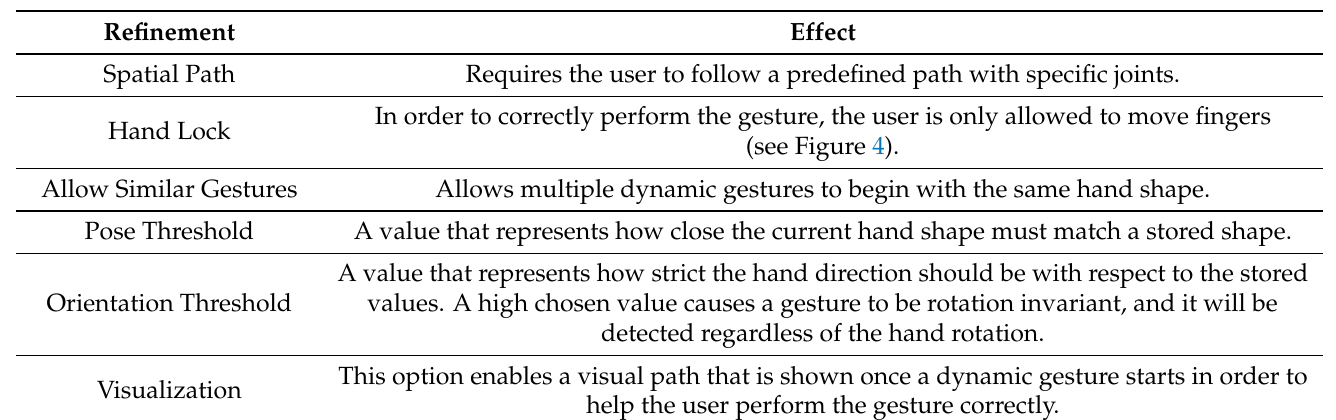
Table 2. Various options can be applied to refine gestures in order to implement desired